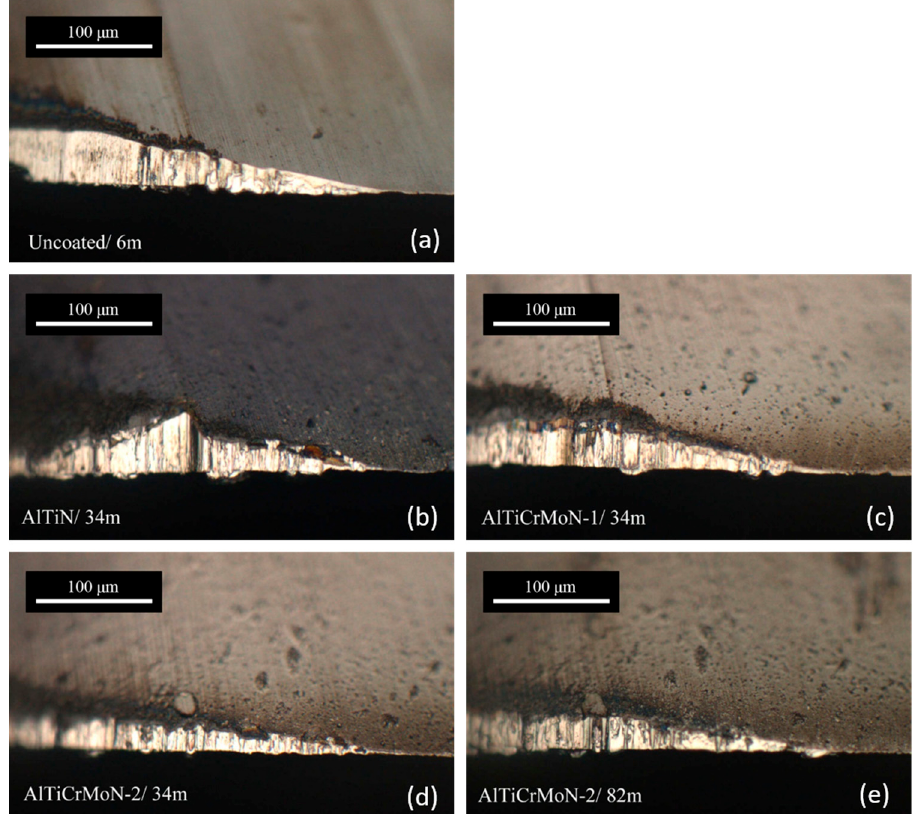
Figure 7. Tool wear images of the uncoated and AlTiN, AlTiCrMoN-1 and AlTiCrMoN-2 coated end mills after machining of SUS316L stainless steel after cutting lengths of 6 m, 34 m and 82 m. ( a ) Uncoated after cutting length of 6 m; ( b ) AlTiN after cutting length of 34 m; ( c ) AlTiCrMoN-1 after cutting length of 34 m; ( d ) AlTiCrMoN-2 after cutting length of 34 m; ( e ) AlTiCrMoN-2 after cutting length of 82 m.